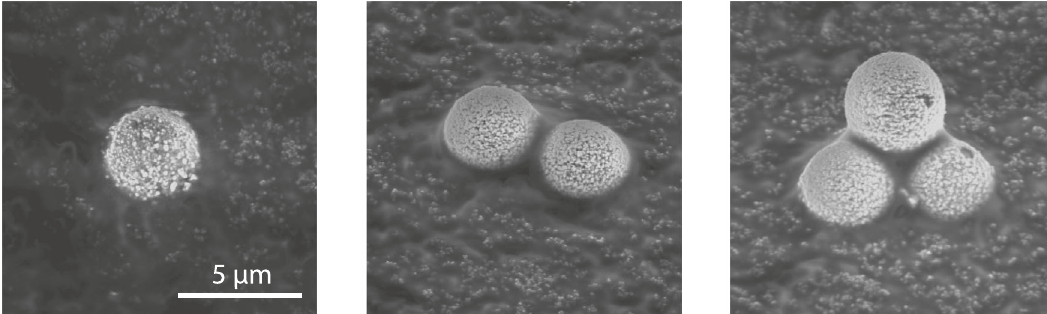
Fig. 2 SEM images of (clustered) microparticles. Three SEM images of the observed (clustered) microparticles including a scale bar which applies to all three pictures. The bottom particles of the triplet (outer most right image) appear smaller than the top particle because these were slightly pressed into the adhesive carbon tape caused by the collection method.